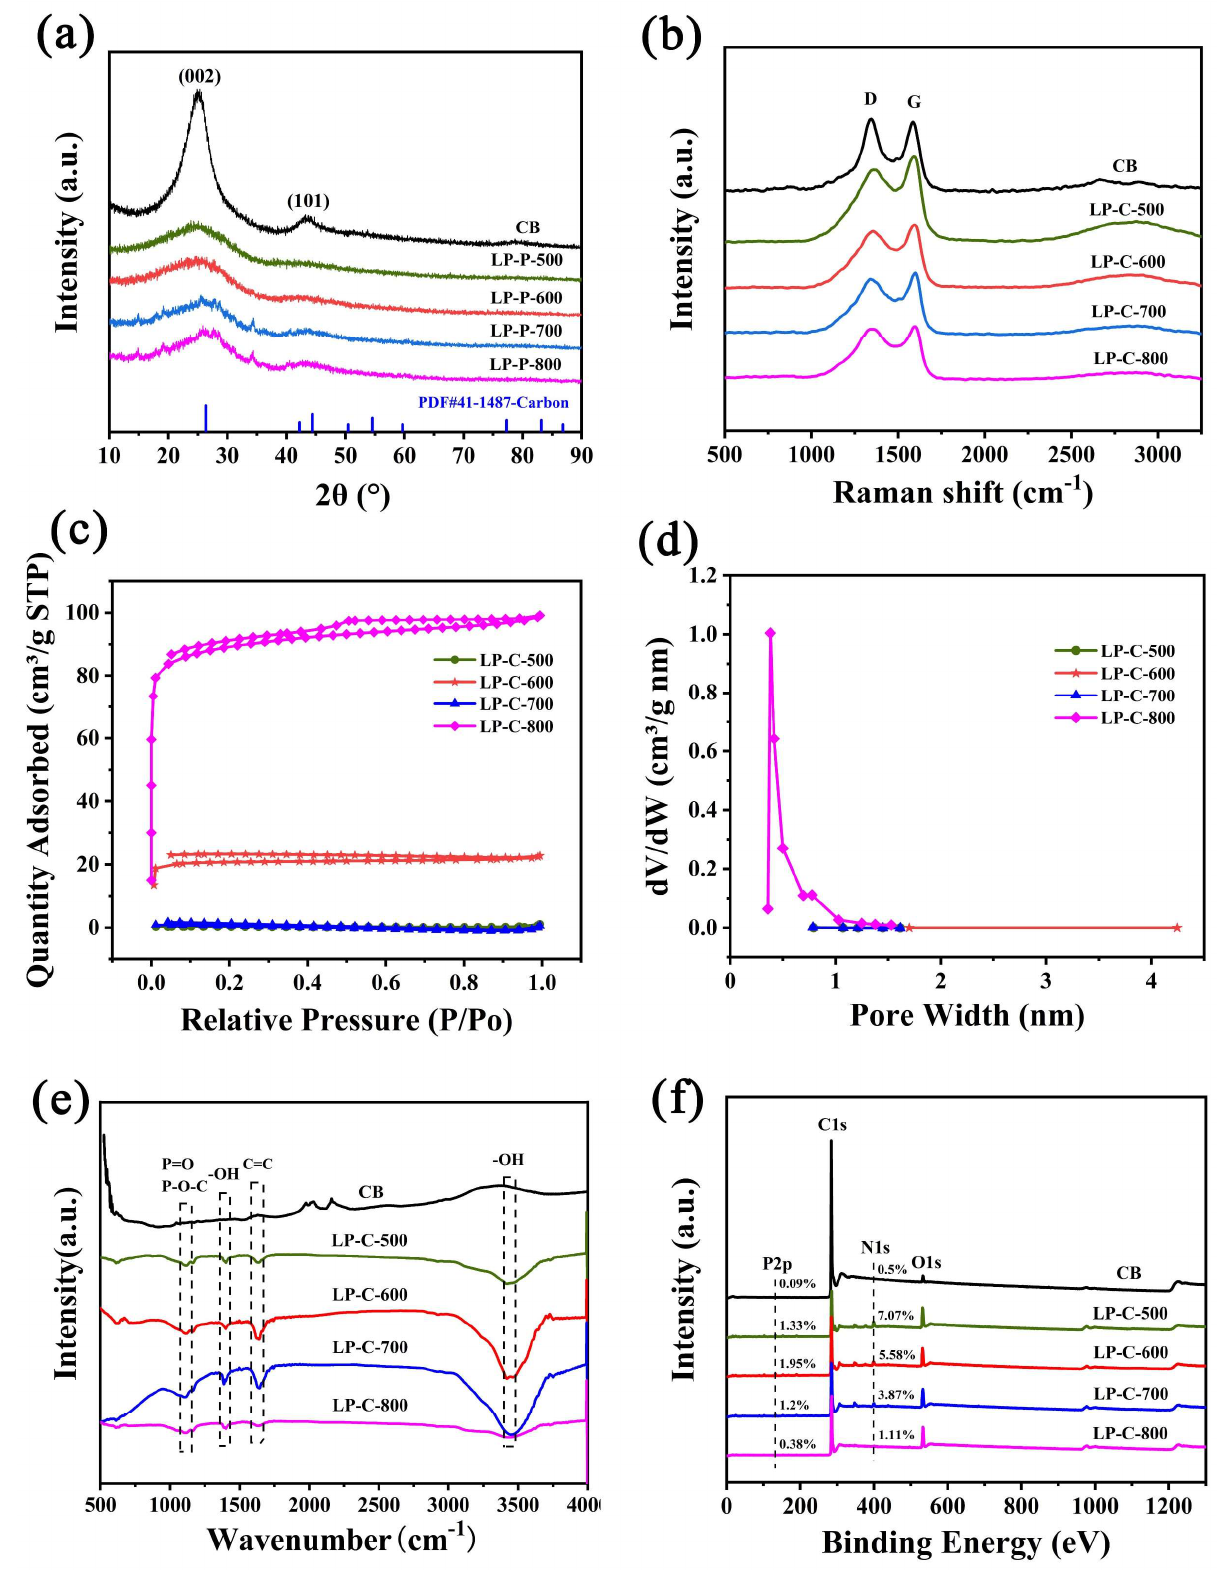
Figure 4. ( a ) X-ray diffraction patterns, ( b ) Raman spectroscopy, ( c ) N 2 adsorption–desorption isotherms; ( d ) pore size distribution, ( e ) FT-IR spectroscopy, and ( f ) XPS spectra of samples.